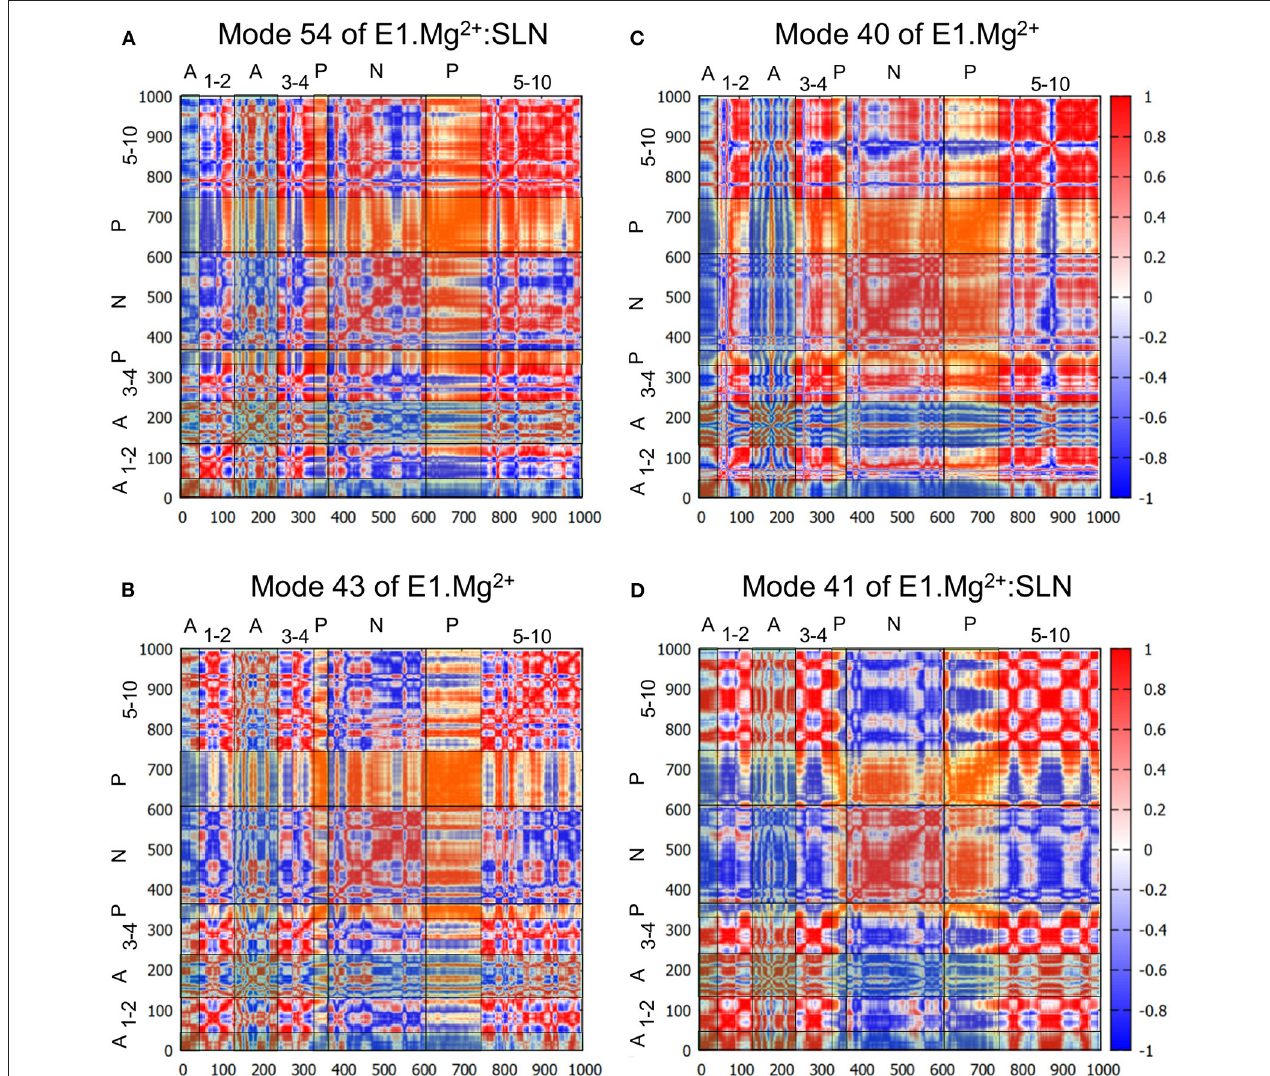
FIGURE 4 | Correlation heatmaps. The correlations are calculated from modes 54 (A) and 41 (D) of E1.Mg 2 + :SLN and modes 43 (B) and 40 (C) of E1.Mg 2 + . The red color corresponds to high correlations, white to the absence of correlations, and blue to high anticorrelations. However, to facilitate the delimitation of the cytosolic domains, transparent vertical and horizontal strips were overlaid on each heatmap, with the following color code: N-domain: gray, P-domain: yellow, and A-domain: cyan, which modifies the perception of the correlation colors. The names of the domains are added on the top and the left of each heatmap, where the numbers refer to the TM